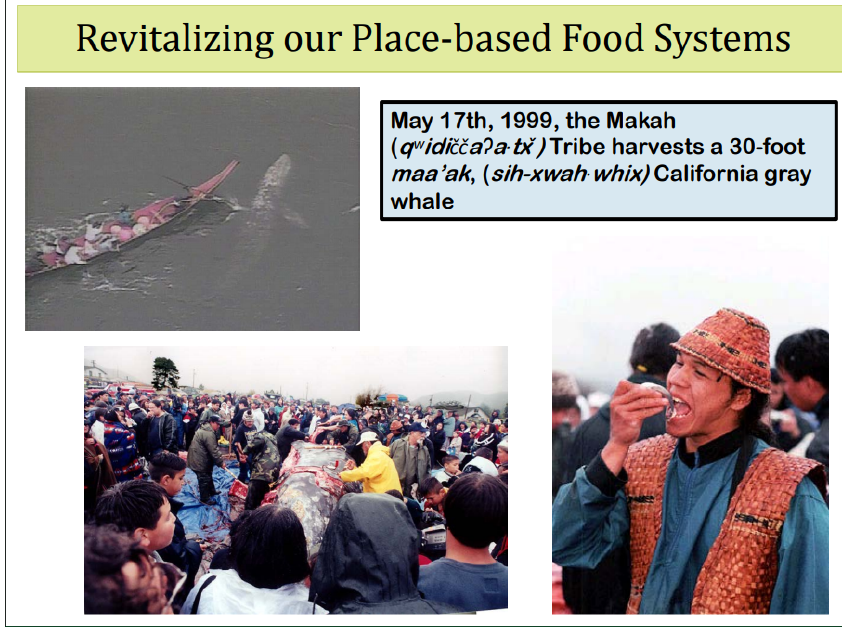
Figure 2. The 1999 Makah Harvest of